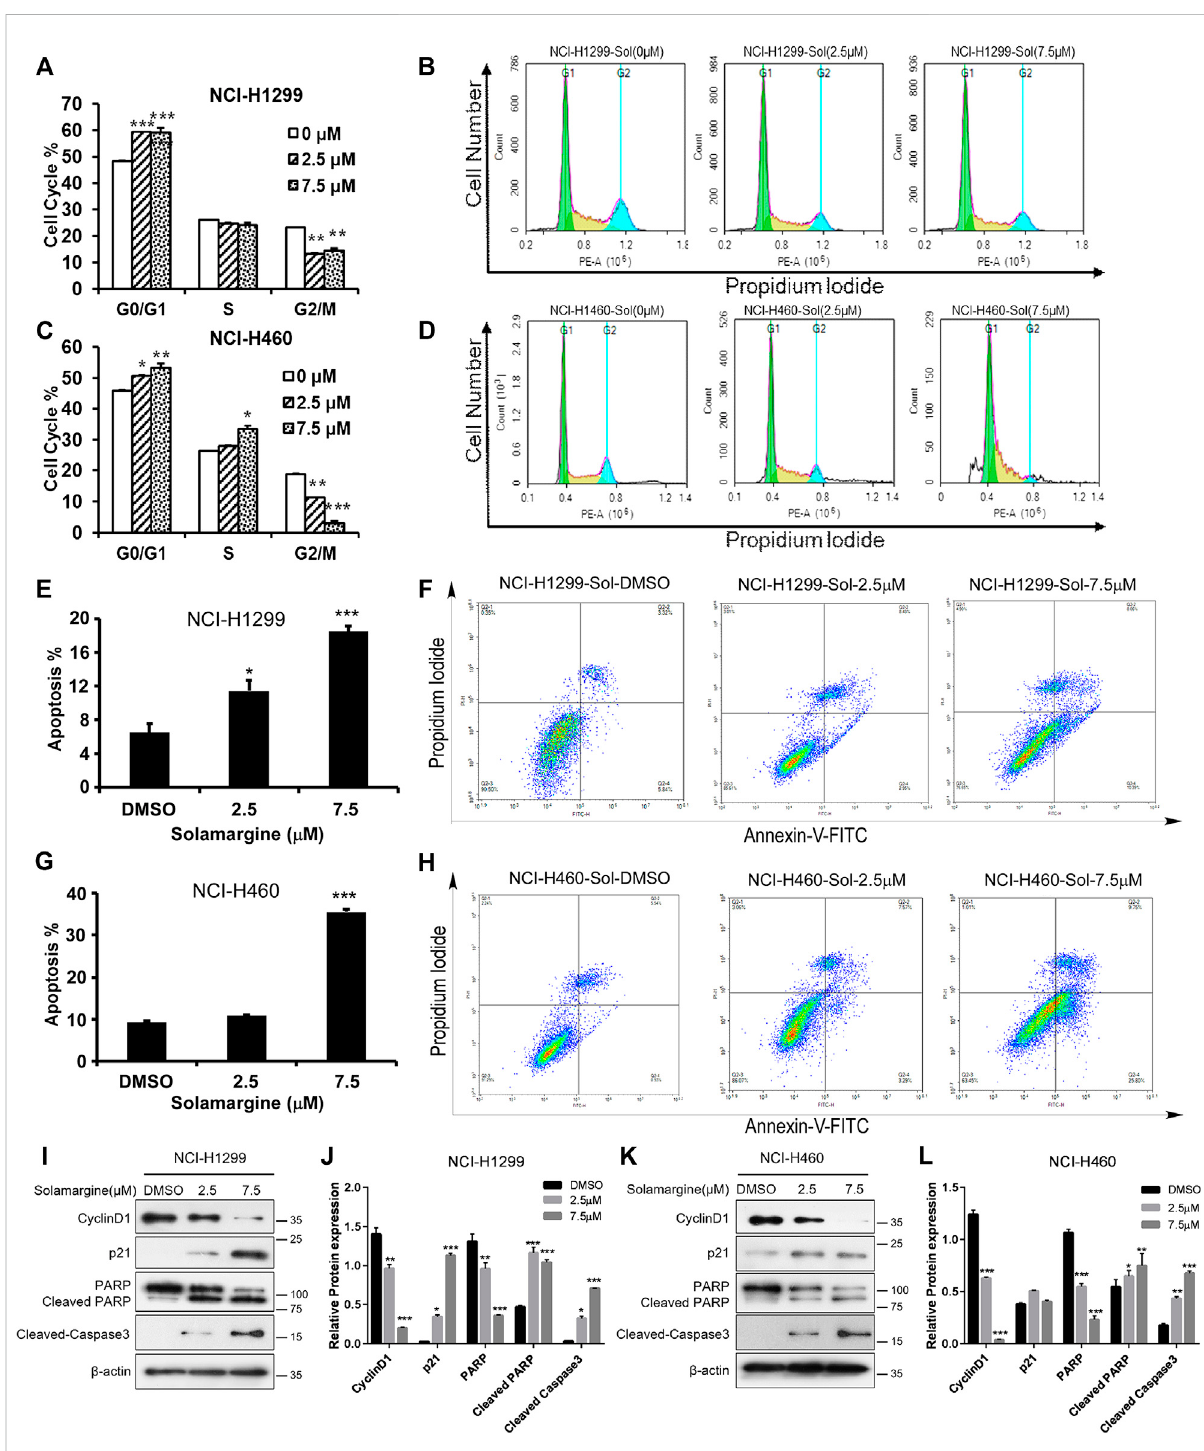
FIGURE 3 Solamargine induced G1/G0 arrest and apoptosis in NCI-H1299 and NCI-H460 cells. (A – D) Flow cytometry analysis of cell cycle by PI staining inNCI-H1299andNCI-H460cellswithtreatmentofDMSOorSolamarginefor48 h.N=3. (E – H) Flowcytometryanalysisofapoptosisanalysisby p I/ AnnexinV-FITCstaininginbothNCI-H1299andNCI-H460cellswithtreatmentofDMSOorSolamarginefor48h.N=3. (I – L) Cellcycleandapoptosis markers (cyclinD1, p21, PARP, cleaved-PARP and cleaved-caspase 3) analysis by western blot for NCI-H1299 and NCI-H460 cells with treatment of DMSO or Solamargine for 48 h β -Actin was used as a loading control. N = 3. One-way ANOVA was used for statistical tests.* p < 0.05, ** p < 0.01, *** p <